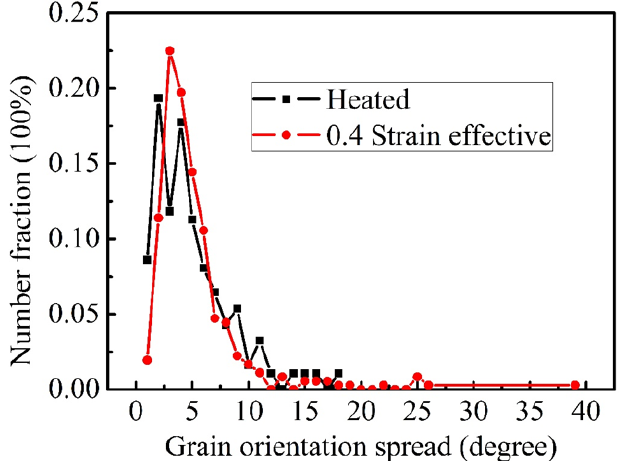
Figure 8. GOS distribution of the specimens after heated at 1040 ° C and deformed to a 0.4 effective strain.